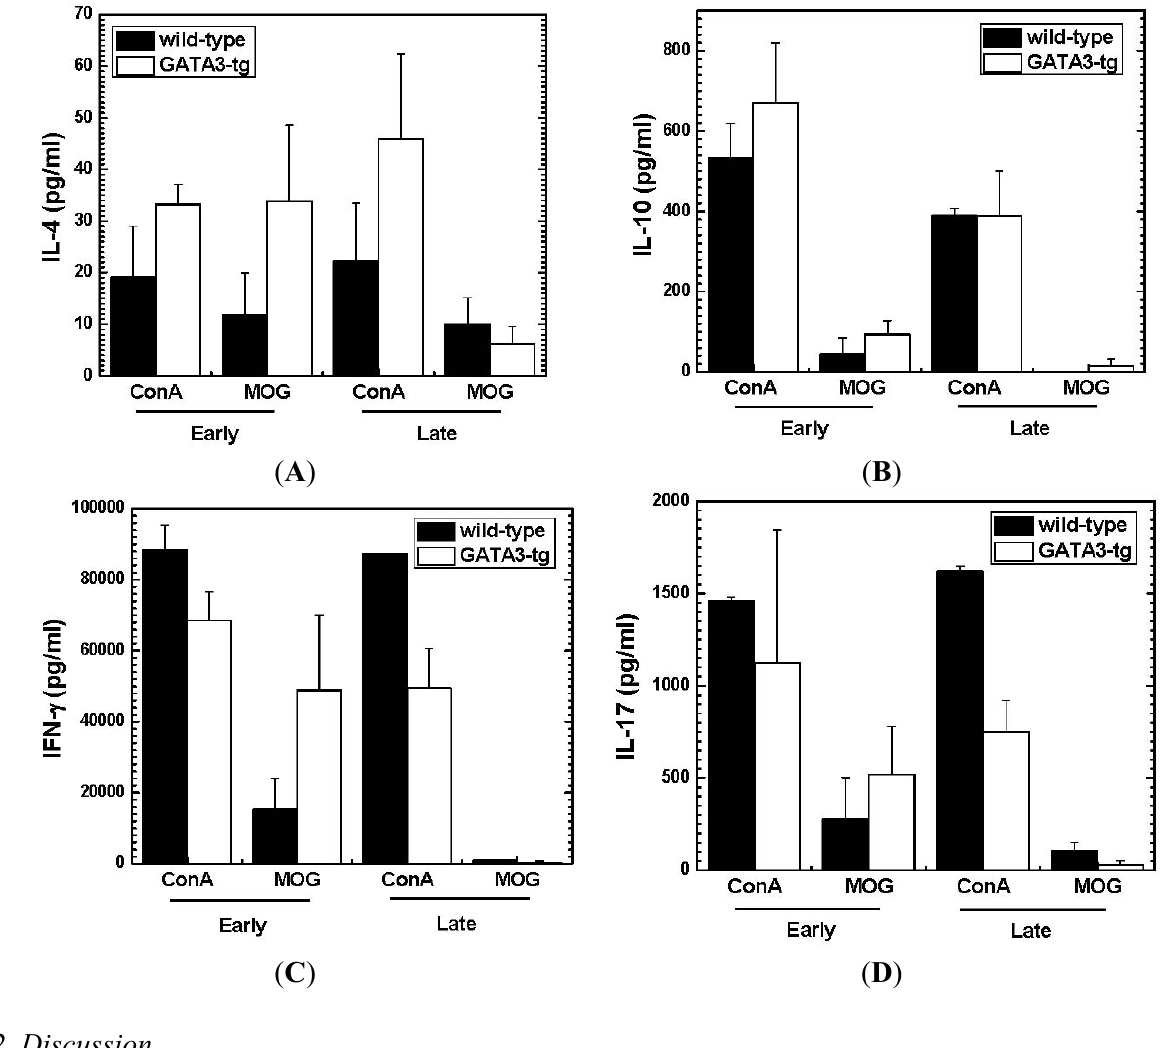
Figure 6. Cytokine profiles of wild-type and GATA3-tg mice with EAE. MNCs were stimulated with concanavalin A (ConA) or MOG. The levels of IL-4 ( A ); IL-10 ( B ); IFN- γ ( C ); and IL-17 ( D ) were measured by enzyme-linked immunosorbent assays (ELISA). During the early stage (two weeks p.i.), levels of IL-4 and IL-10 were higher in GATA3-tg mice after MOG or ConA stimulation. During the late stage (two months p.i.), MOG stimulation did not induce substantial cytokine production, while ConA stimulation induced higher IL-4, and lower IFN- γ and IL-17 in GATA3-tg mice. Cytokine assays were conducted in duplicate wells, using lymph nodes that were pooled from two to three mice. Values are mean + SEM of two to three pools of lymph node cells and are representative of two independent experiments (total numbers of samples: acute stage, 14 samples in six pools; chronic stage, 13 samples in six